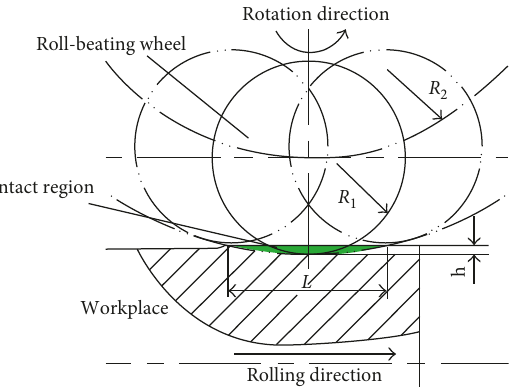
Figure 8: Schematic of the contact area, in which a roll-beating wheel beats the